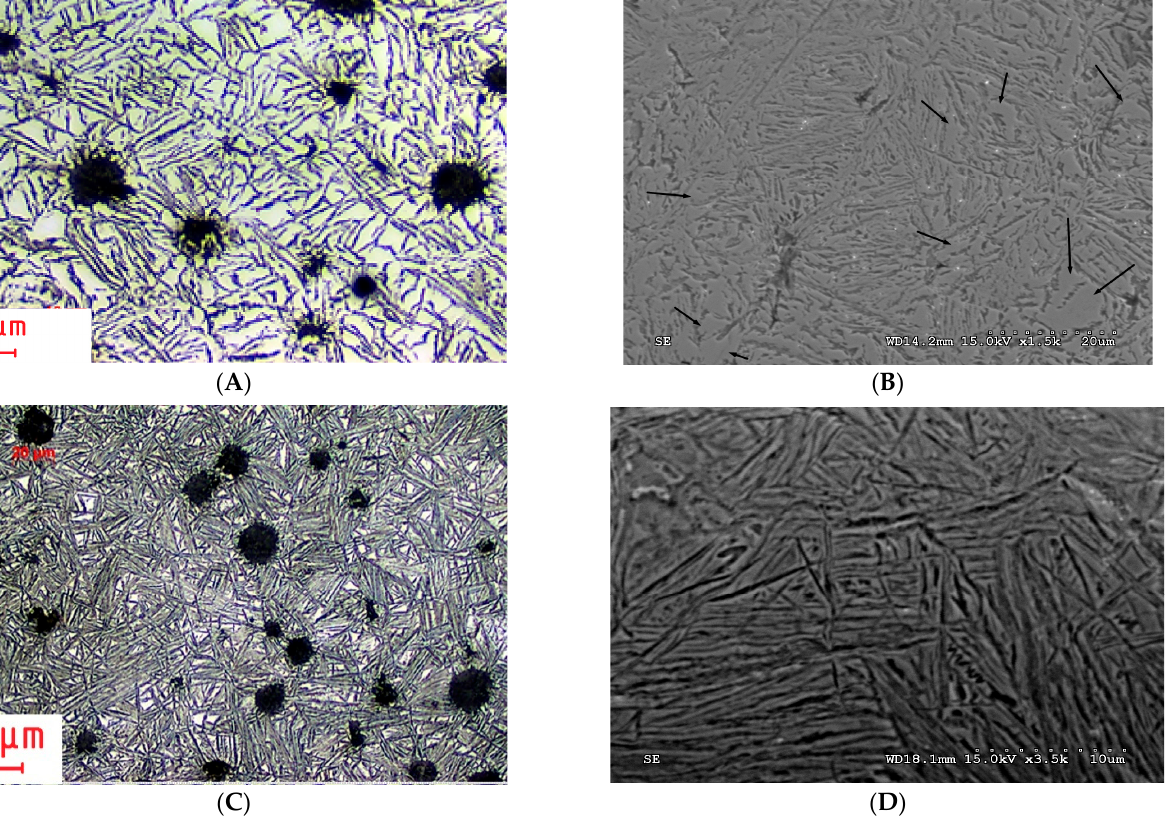
Figure 2. Views of the structure of the tested cast irons. ( A ) The microstructure of the ADI_360 matrix with the visible structure of upper ausferrite (OM). ( B ) Block austenite (marked by arrows) in the ADI_360 matrix (SEM). ( C ) The microstructure of the ADI_310 matrix (OM). ( D ) The microstructure of the ADI_240 matrix (SEM).